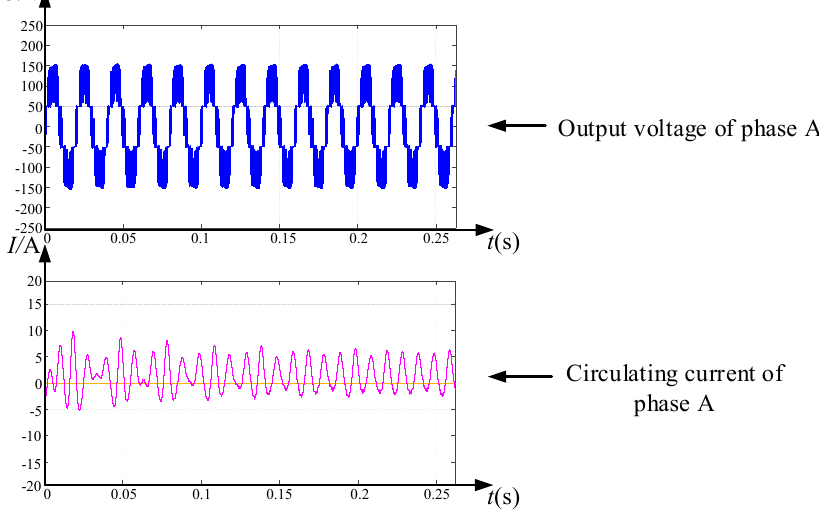
Figure 6. Waveform of the output voltage and the circulating current of phase A when θ = π / N .